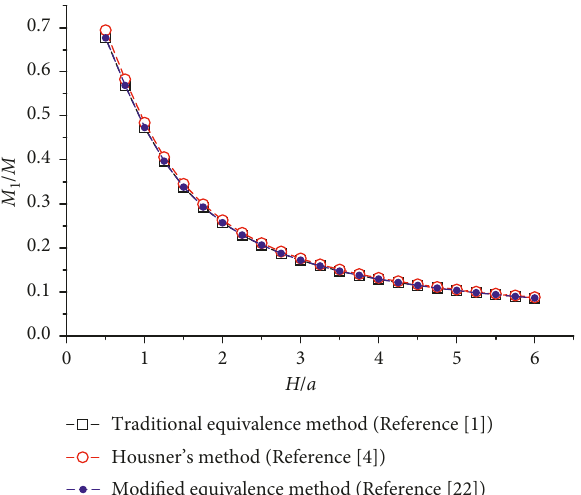
Figure 3: Mass ratio M angular tank).